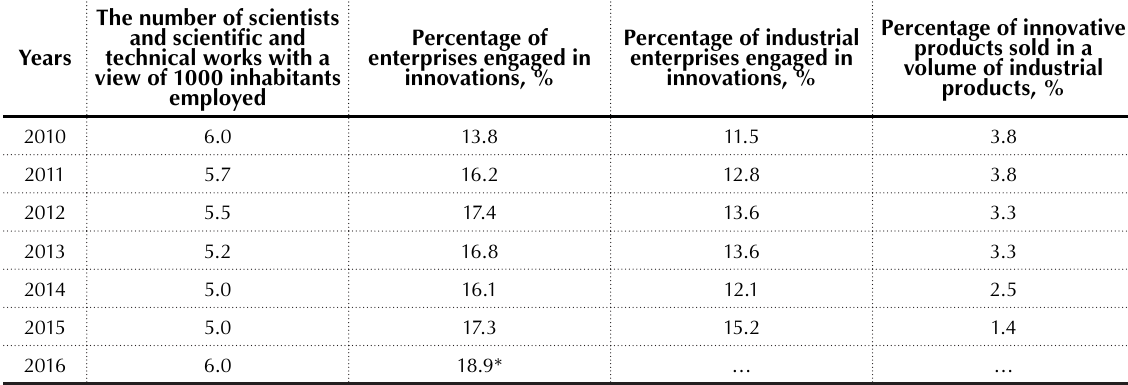
Table 8. Indicators of innovation activity in